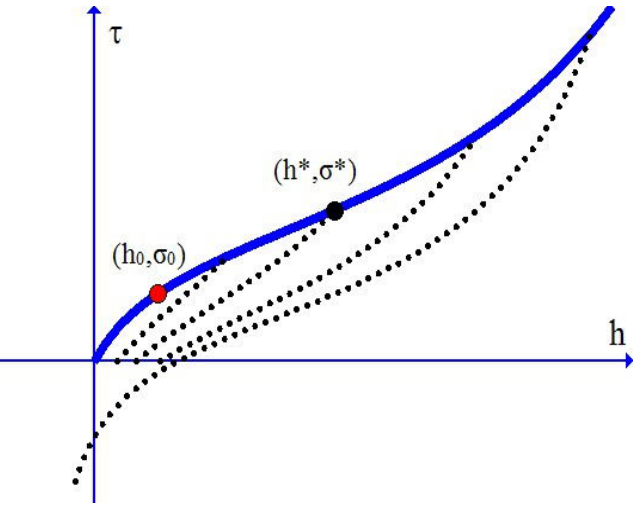
Figure 1. Stress softening with unloading curves of different